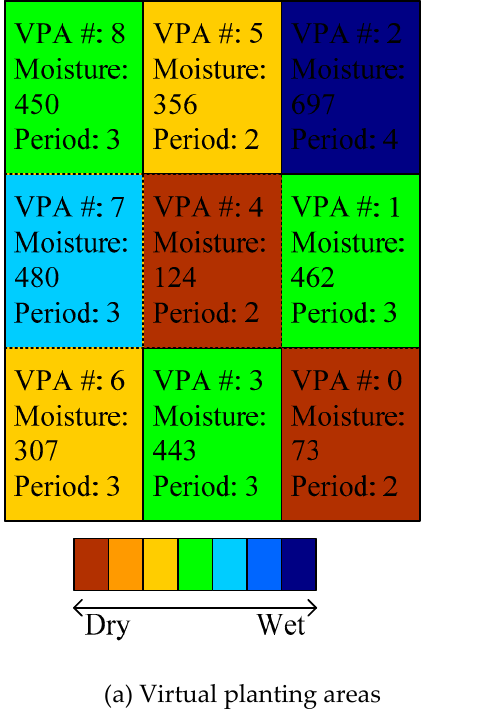
Figure 2. SIU components implementation. ( a ) The cultivated field is divided into multiple virtual planting areas. CDU applies different irrigation periods for each virtual planting area (VPA). ( b ) The moisture probing and irrigation components of the CAIS. CAIS uses one motor to control these two components.